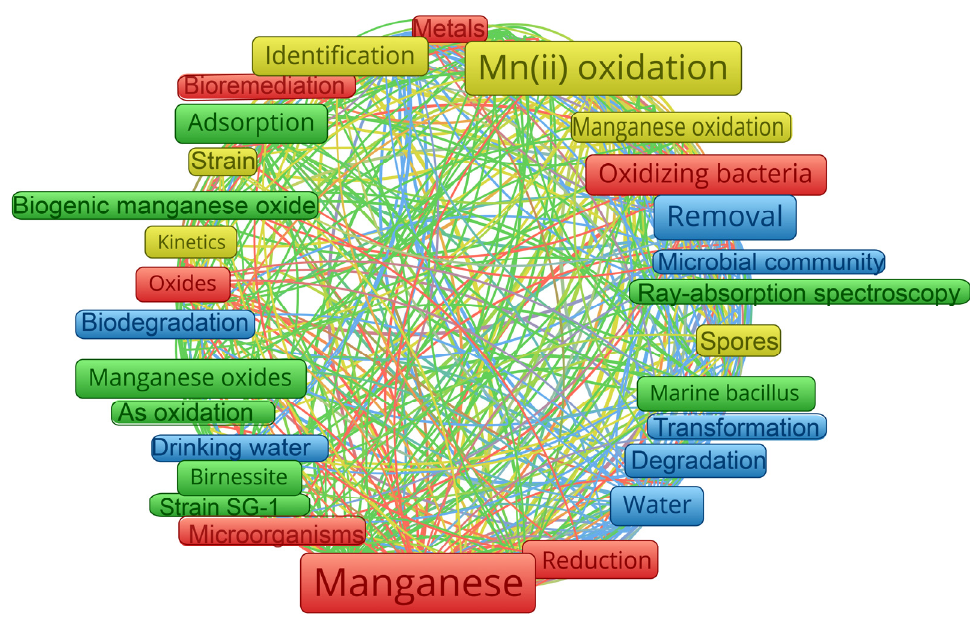
Figure 2. Network view map of 859 publications in the literature, generated by using VOSviewer.